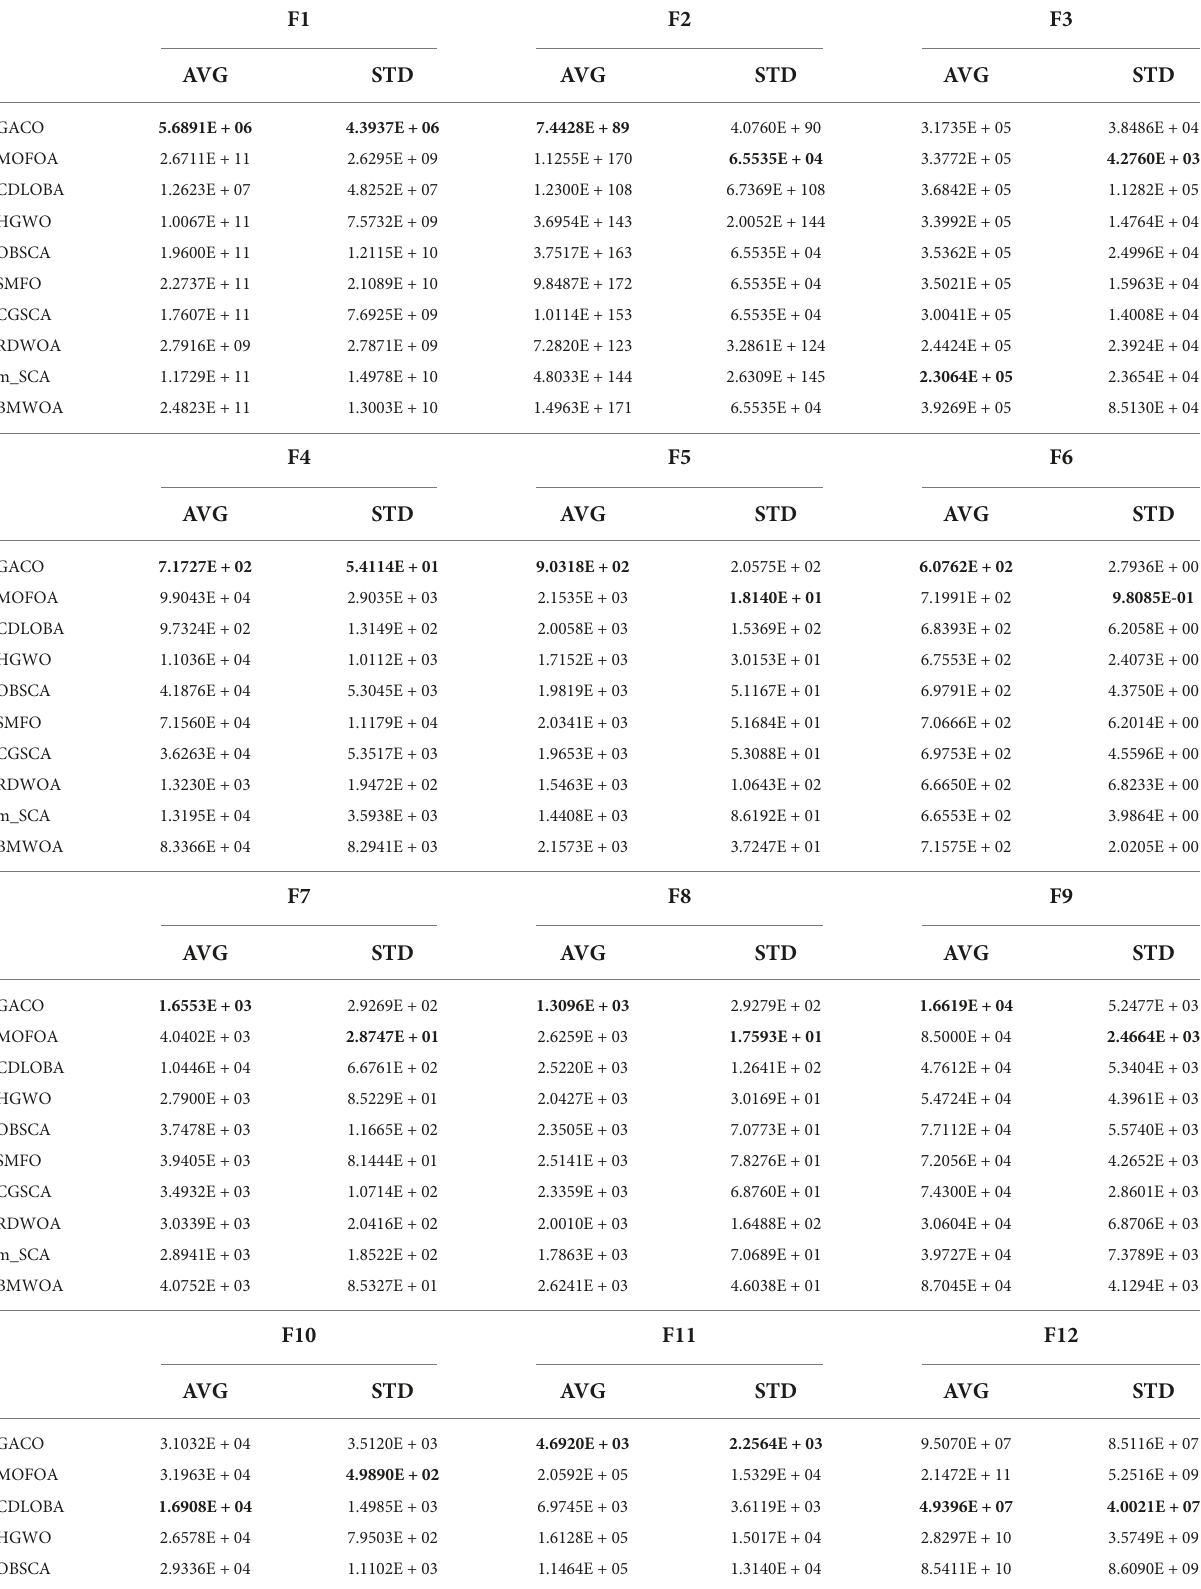
TABLE 8 The average values and standard deviations of GACO and nine advanced